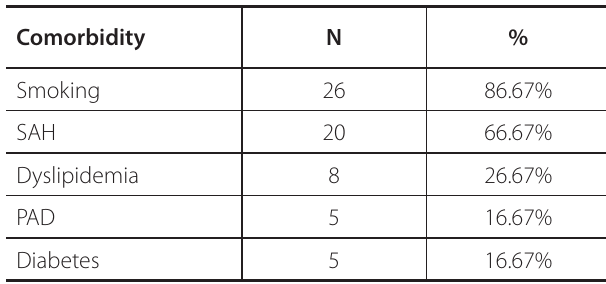
Table 2 . Comorbidities.